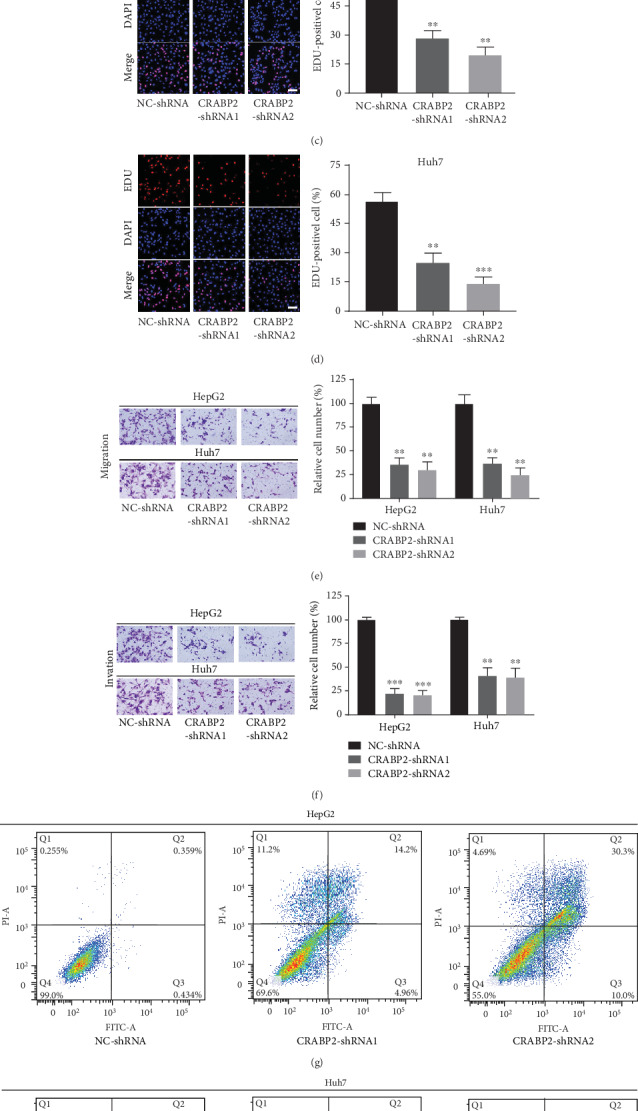
Effects of CRABP2 on cell proliferation, metastasis, and apoptosis. (a, b) CCK-8 assays were carried out to assess the cell viability of HpeG2 and Hun7 cells after transfection with CRABP2-shRNAs. n = 8. (c, d) Cell proliferation of HpeG2 and Hun7 cells was determined by EDU staining, the positive cell rate was analyzed by Image-Pro Plus software, n = 8. Scale bar = 50 μm. (e, f) Migration and invasion of HpeG2 and Hun7 cells was assessed by Transwell assay (200x); the relative cell number rate was analyzed by Image-Pro Plus software. n = 10. (g, h) CRABP2-shRNA transfection increased HpeG2 and Hun7 cell apoptosis in flow cytometry. n = 8. One-way ANOVA was used in multigroup comparison. All data are presented as mean ± SEM. ∗∗P < 0.01, ∗∗∗P < 0.001 vs. NC-shRNA.